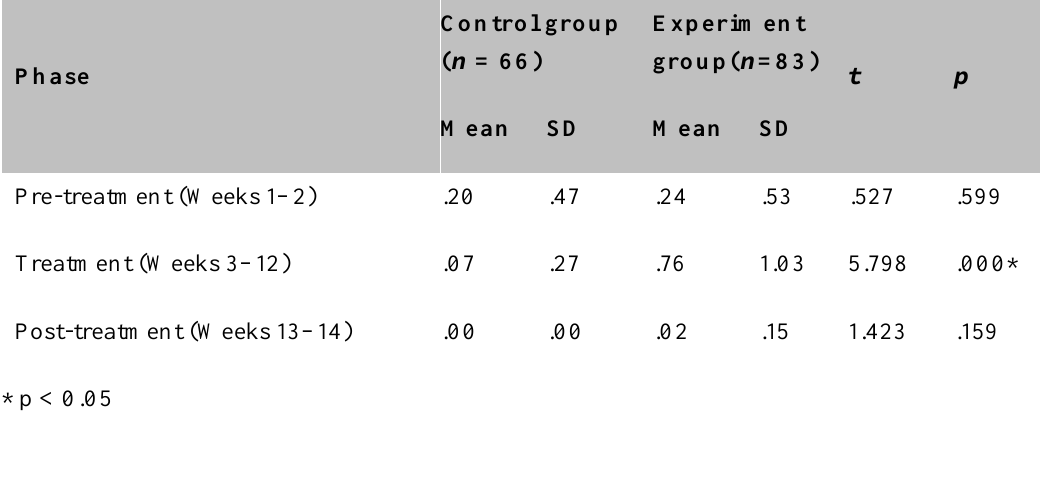
Descriptive Statistics and T-Test Results of the Number of Help Requests Made by Learners